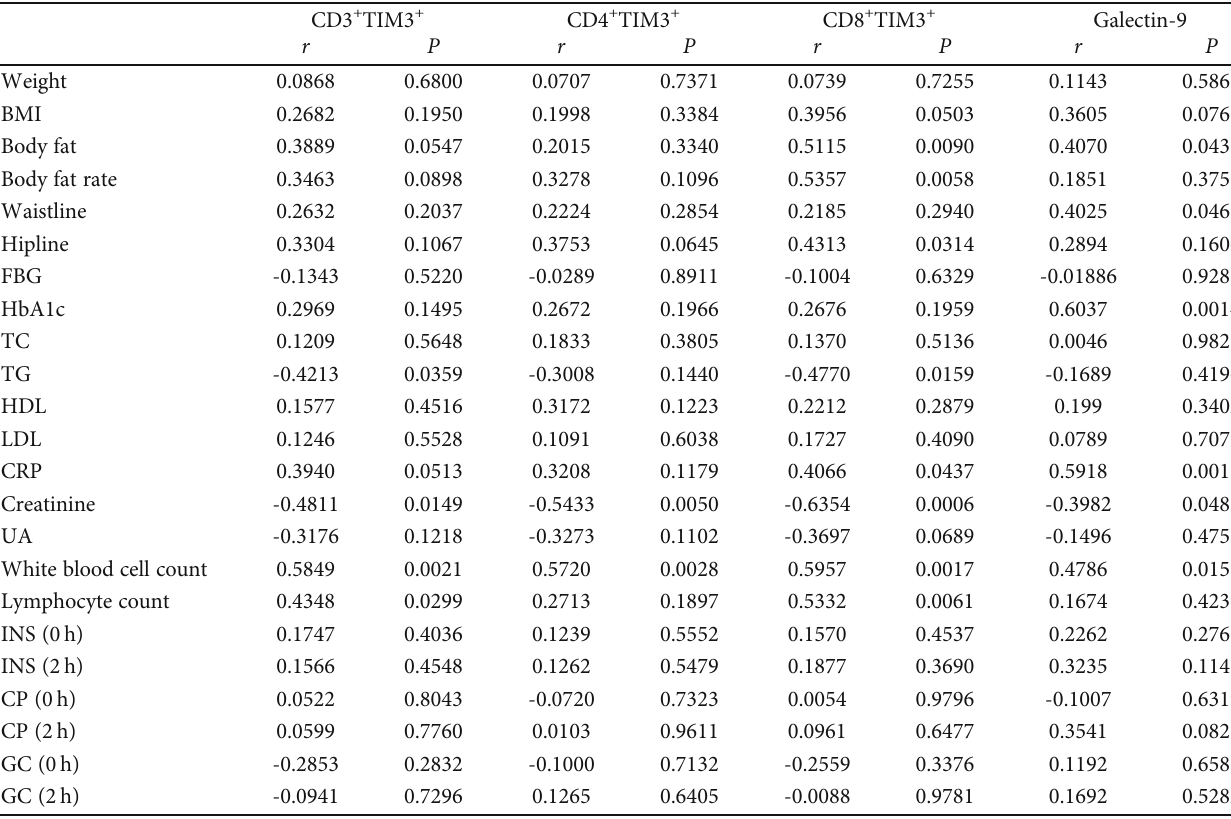
Table 2: Correlation between TIM3, galectin-9, and clinical indicators in simple obesity